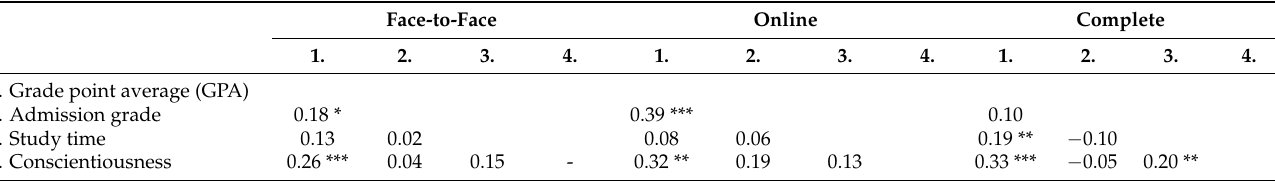
Table A1. Pearson’s correlation coefficient using the complete data set.